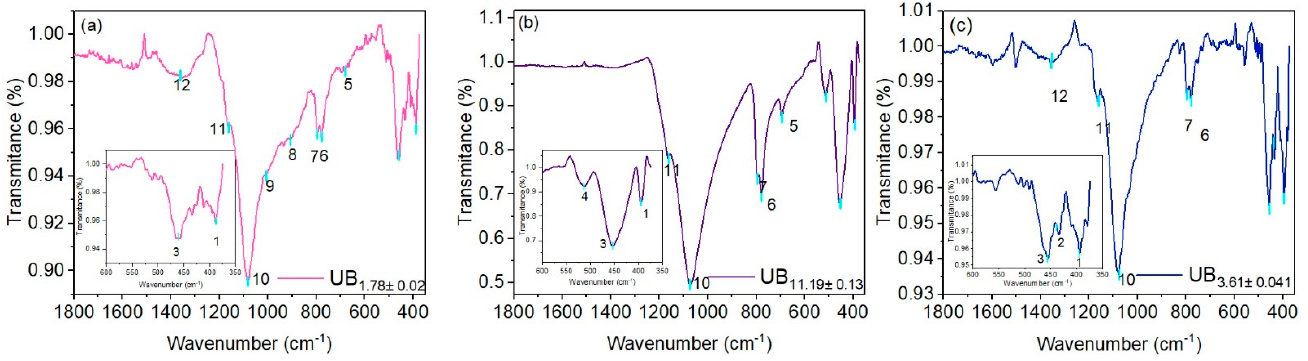
Figure 5. Infrared spectra of ( a ) UB 1.78 , ( b ) UB 11.19 , and ( c ) UB 3.61 . The blue spots correspond to the main bands. Table 6. Values of the main FTIR bands (cm − 1 ). For UB 4 extracted from the literature, dd corresponds to doubly degenerate mode. For ZrB 12 , the numbers in bold are the active IR bands defined by the authors, with a star are the active IR bands defined by the Bilbao crystallographic database, and in italic are the active Raman bands. The frequencies presented for UB 12 from ref. [52] correspond to Raman modes.